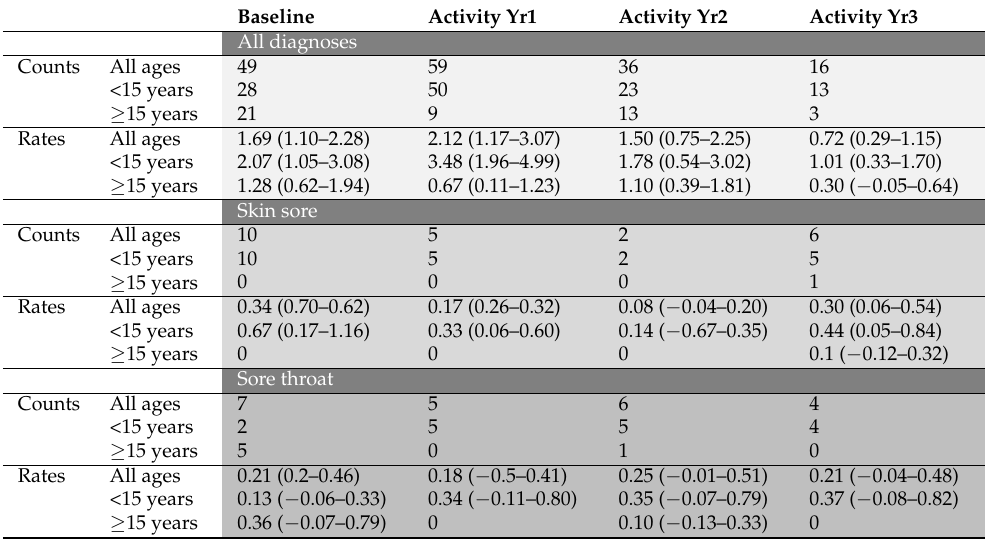
Table 3. Clinic data for diagnoses of interest in primary